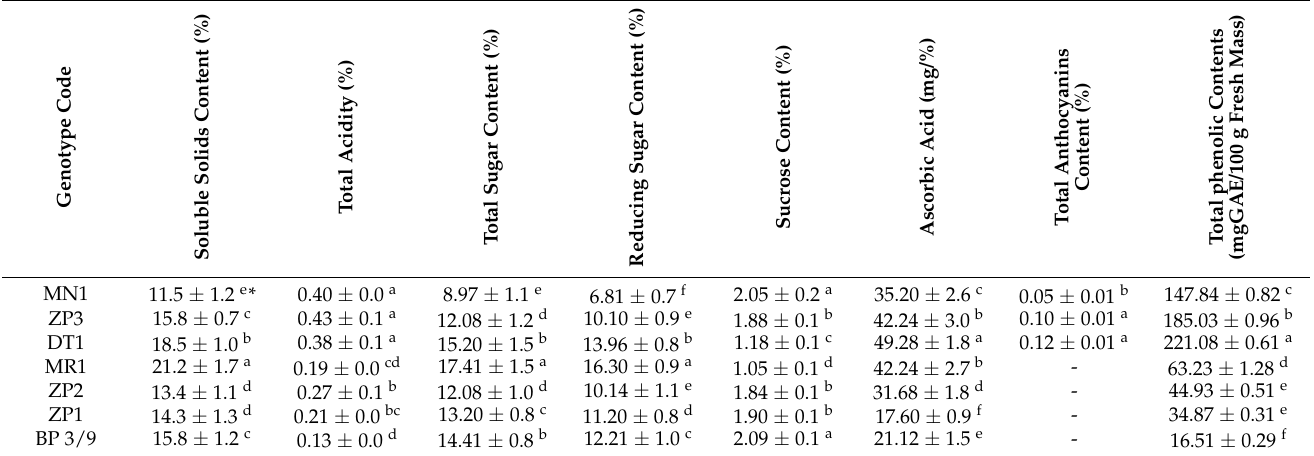
Table 5. Chemical composition of investigated mulberry